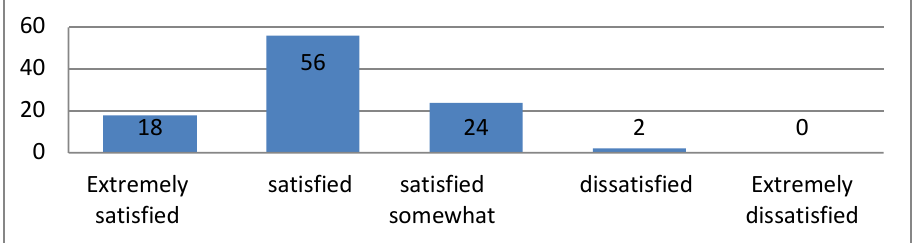
Figure 6 : You have flexible amount of choice in deciding how your job should be